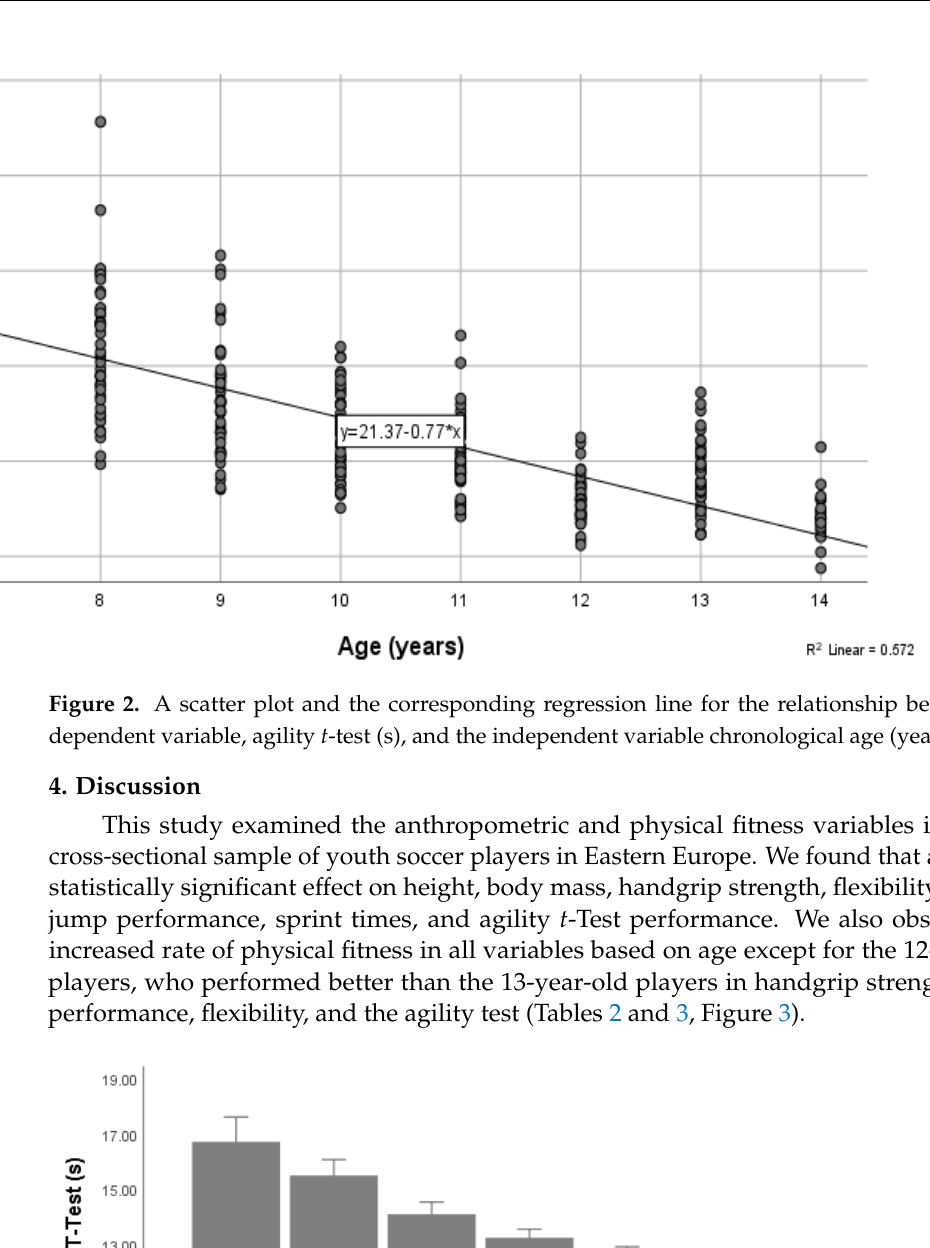
Figure 1. A scatter plot and the corresponding regression line for the relationship between the de- pendent variable, 30-m sprint (s), and the independent variable chronological age (years.).